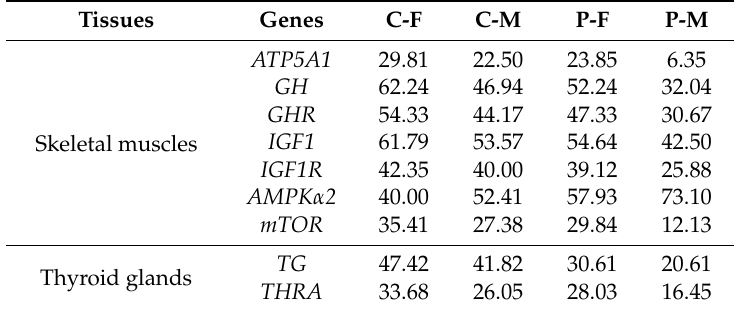
Table 2. DNA methylation levels (%).